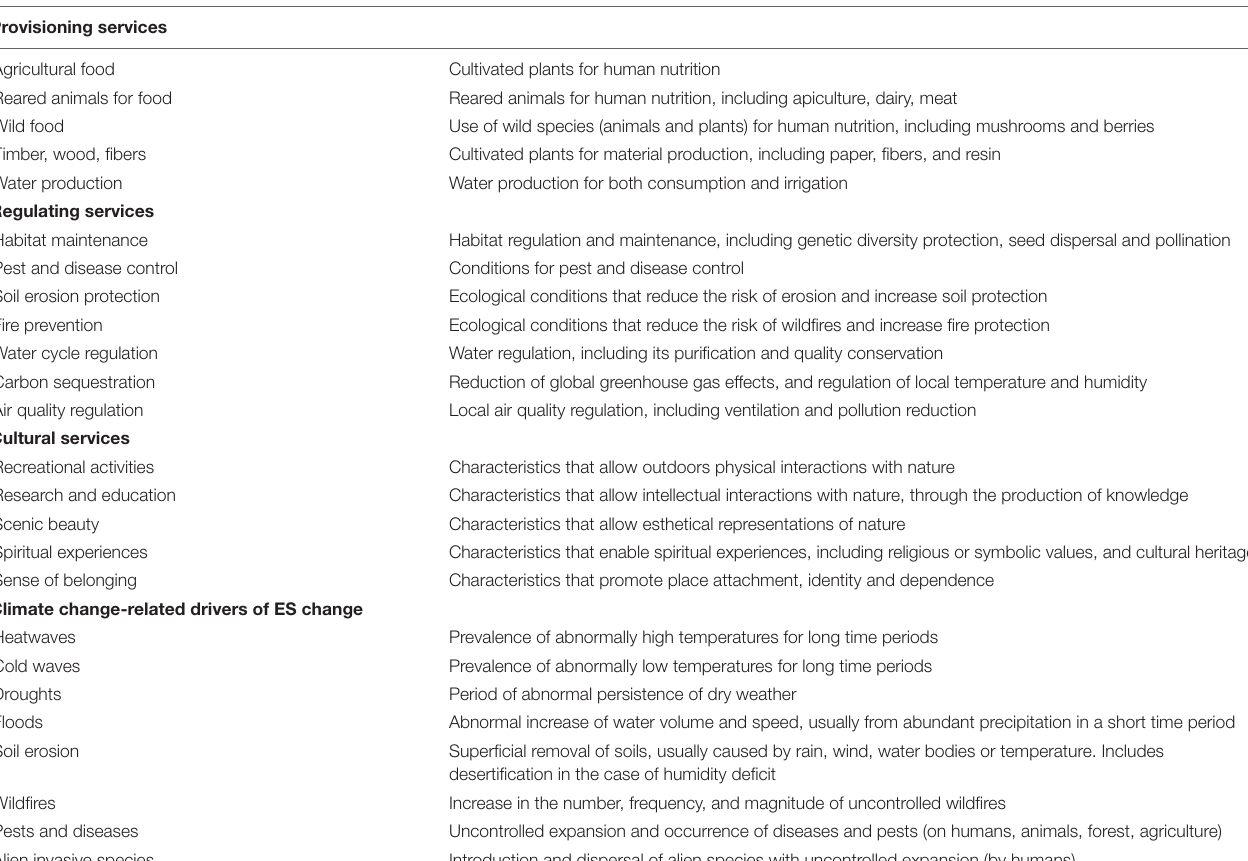
TABLE 1 | Predefined list of ecosystem services (ES) and climate change-related drivers of ES change considered to evaluate the views of public officers on the supply and demand of multiple ecosystem services and the expected climatic impacts during the workshops. Provisioning